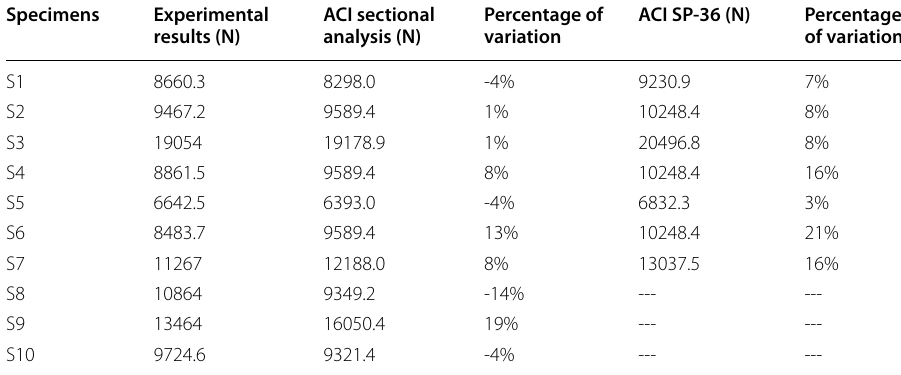
Table 4 Comparison between theoretical results and experimental results for scaled down shear